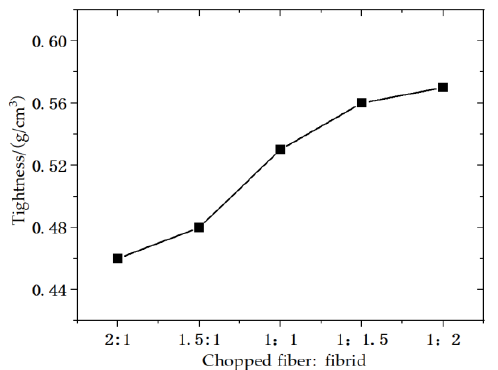
Figure 3. Tightness of insulating paper with different fiber ratios.